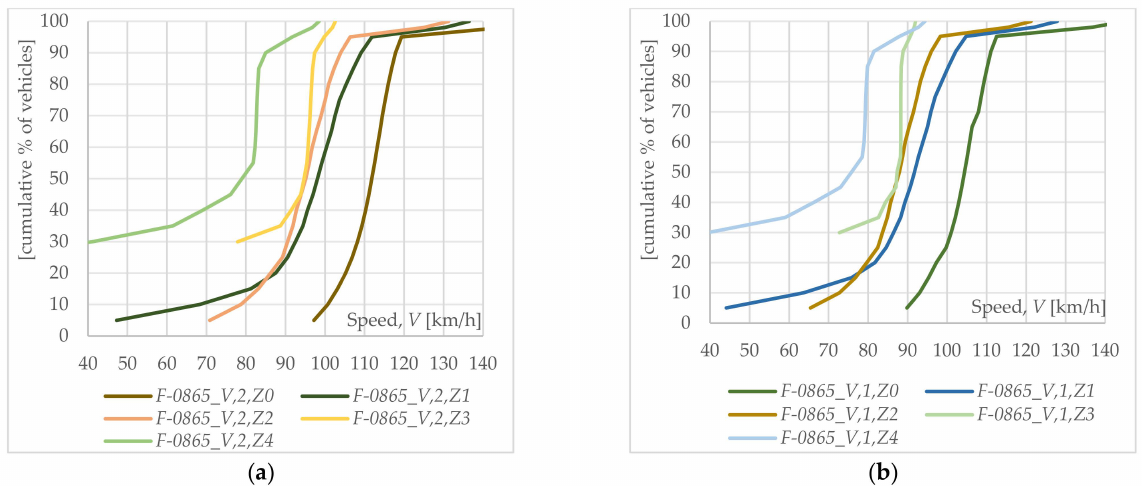
Figure 4. Empirical speed distribution functions with different traffic management measures in the case of wind at test point 0865: ( a ) lane 2—left (overtaking) lane; ( b ) lane 1—right